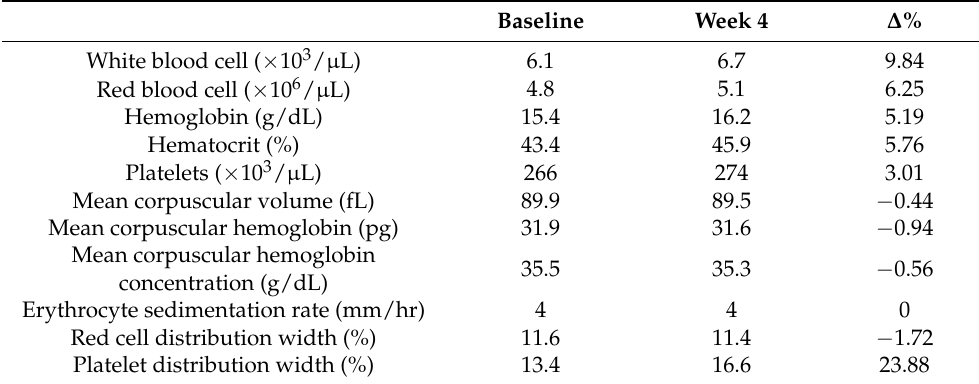
Table 2. Changes in complete blood counts.